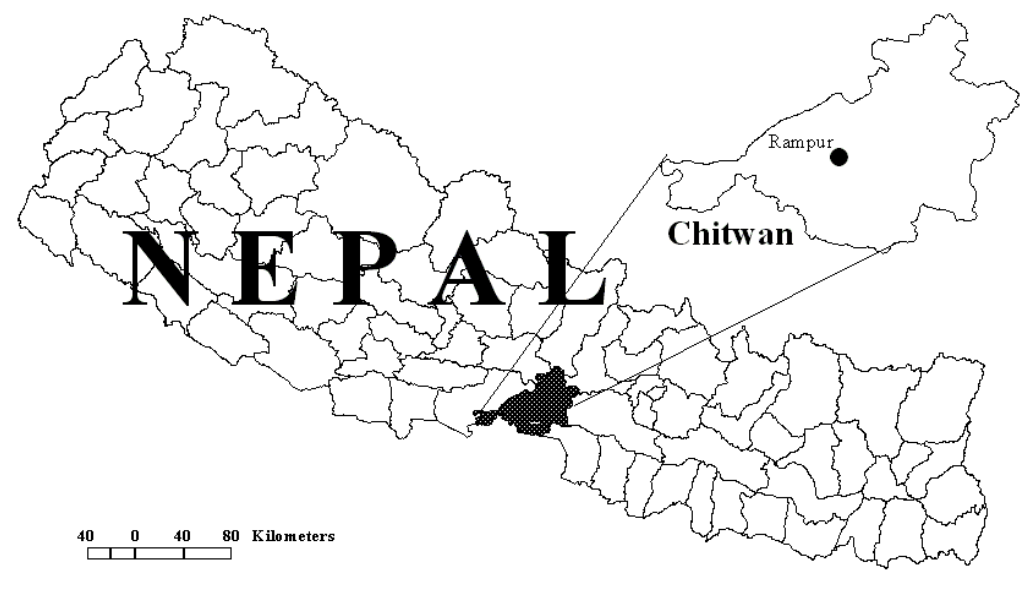
Figure 1. Study sites representing a major vegetable production pocket in